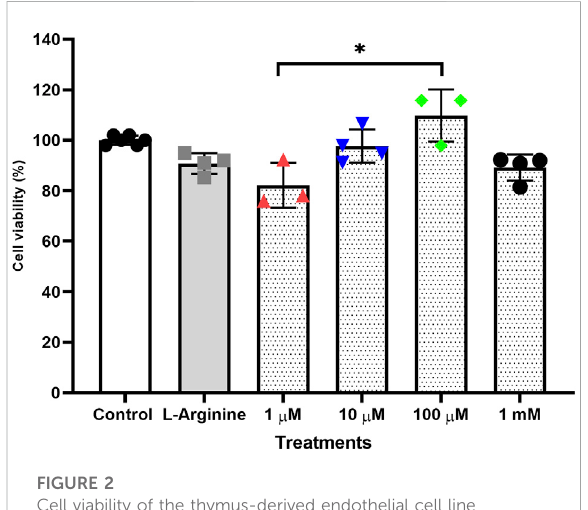
FIGURE 2 Cell viability of the thymus-derived endothelial cell line tEnd.1 aftertreatmentwithL-arginine(100 µM)and L-NAME (1,10, 100 μ M, 1 mM) for 96 h with retreatment. Data were compared by Two-way ANOVA, followed by Tukey ’ s test. (*Represents statistically signi fi cant difference between groups for p < 0.05; **Representsstatisticallysigni fi cantdifferencebetweengroupsfor p < 0.01).